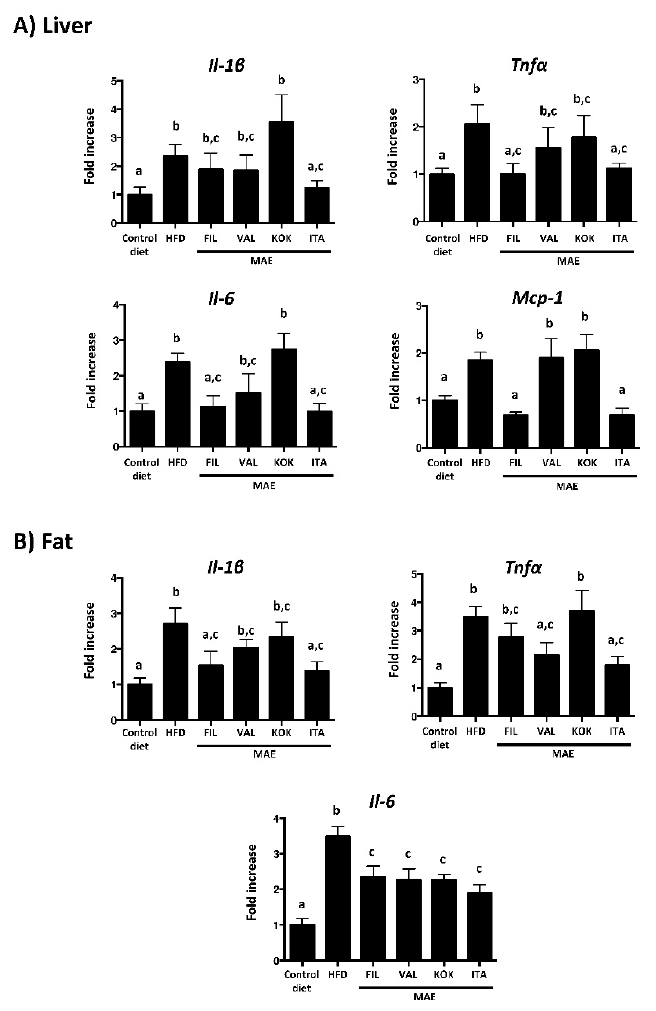
Figure 5. Effects after administration of Morus alba extracts ( genotypes Filipina , Valenciana temprana , Kokuso , and Italia ) in high fat diet (HFD)-fed mice: ( A ) on gene expression of Il-1ß , Tnf- α , Il-6 , and Mcp- 1 in liver ; ( B ) on gene expression of Il-1ß , Tnf- α , and Il-6 in fat, analyzed by real time qPCR. Data are expressed as means ± SEM ( n = 10). Groups with different letters statistically differ ( p < 0.05).